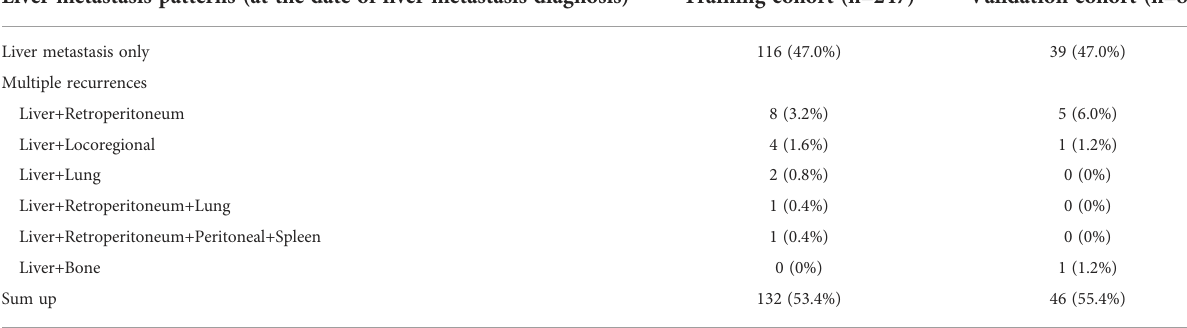
TABLE 2 Recurrence patterns of patients with liver metastasis after the operation. Liver metastasis patterns (at the date of liver metastasis